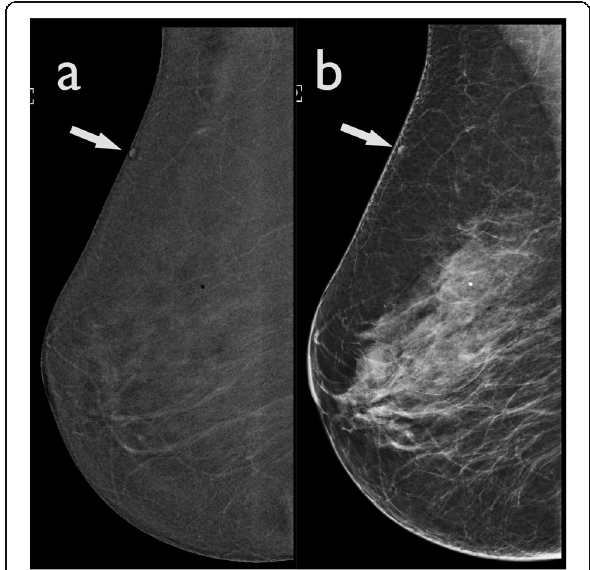
Fig. 14 Enhancement of skin lesions. a The recombined image demonstrates a small oval enhancing lesion in the upper quadrant of the right breast, which could mimic a small enhancing mass (arrow). b The LE CEDM image shows an oval hyperdensity formation in the upper quadrant. Evaluation of the patient ’ s skin in this region confirmed the presence of a small skin angioma Quality control (QC) artefacts These artefacts can severely compromise the image qual- ity. It is important to train all technologists and schedule specific times for the daily QC processes and specific days for the weekly QC processes. It is a good practice to test the system on a phantom prior to the CEDM im- aging schedule.